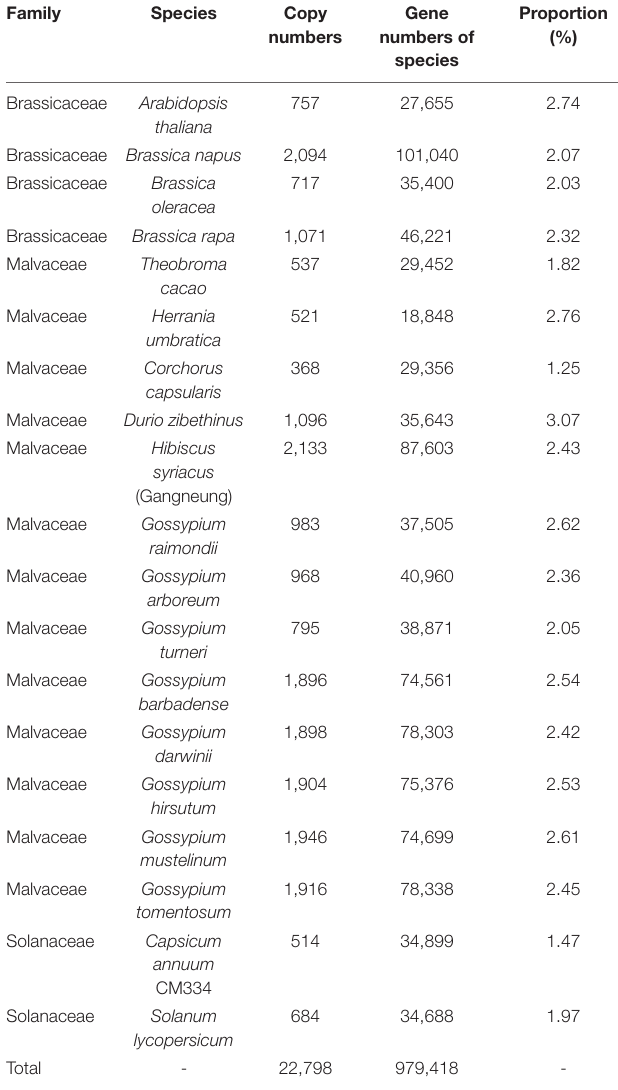
TABLE 2 | Flowering-time genes identified in this